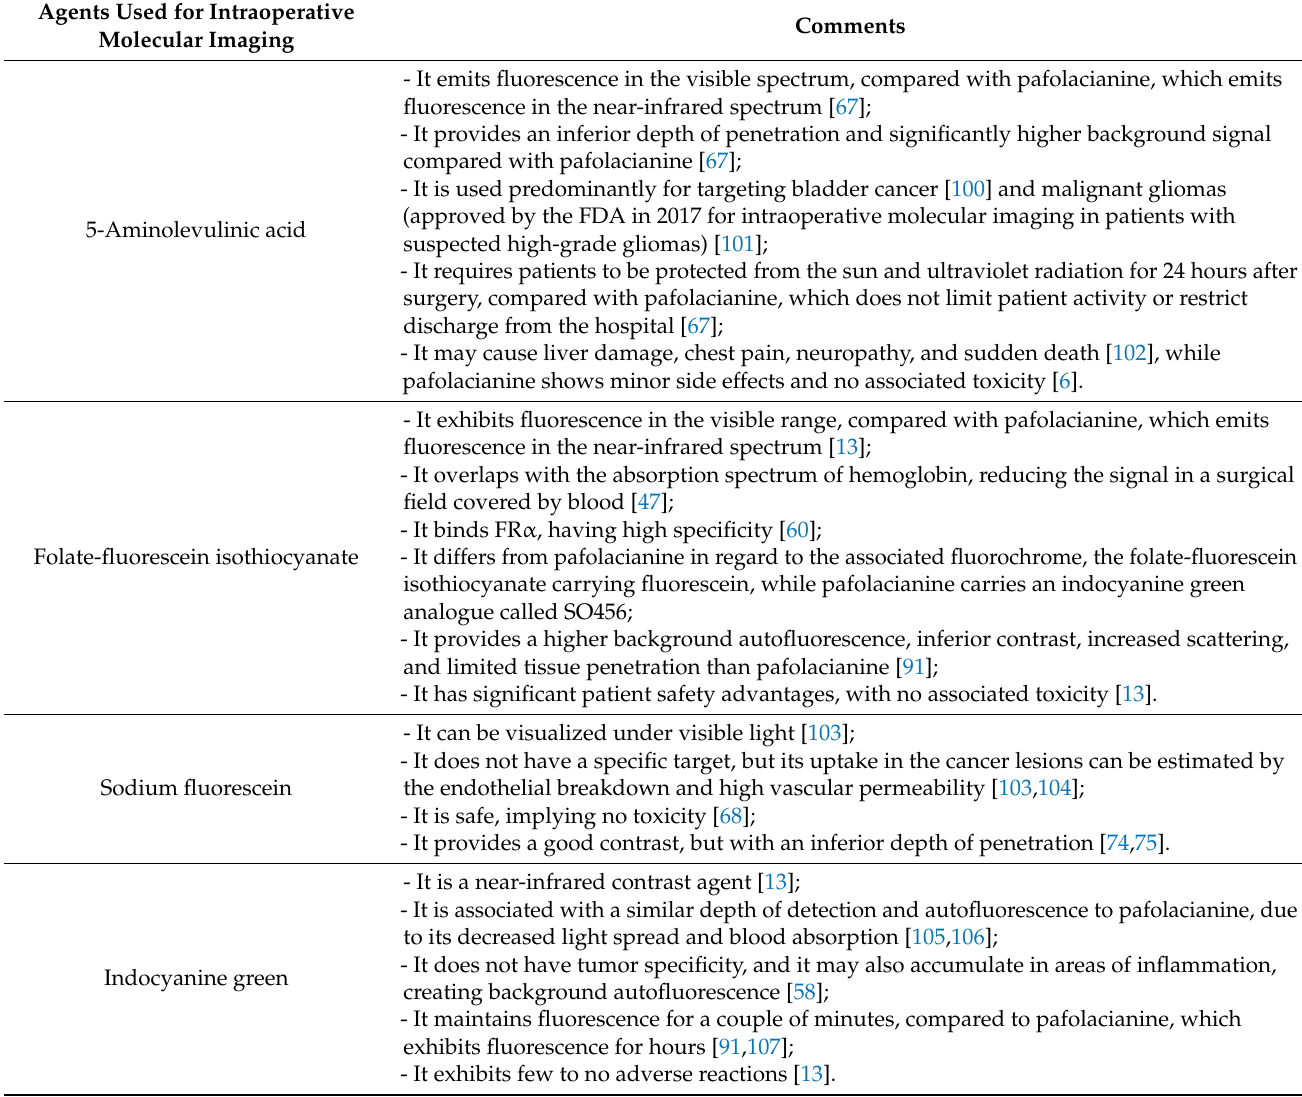
Table 2. Other similar agents used for intraoperative tumor